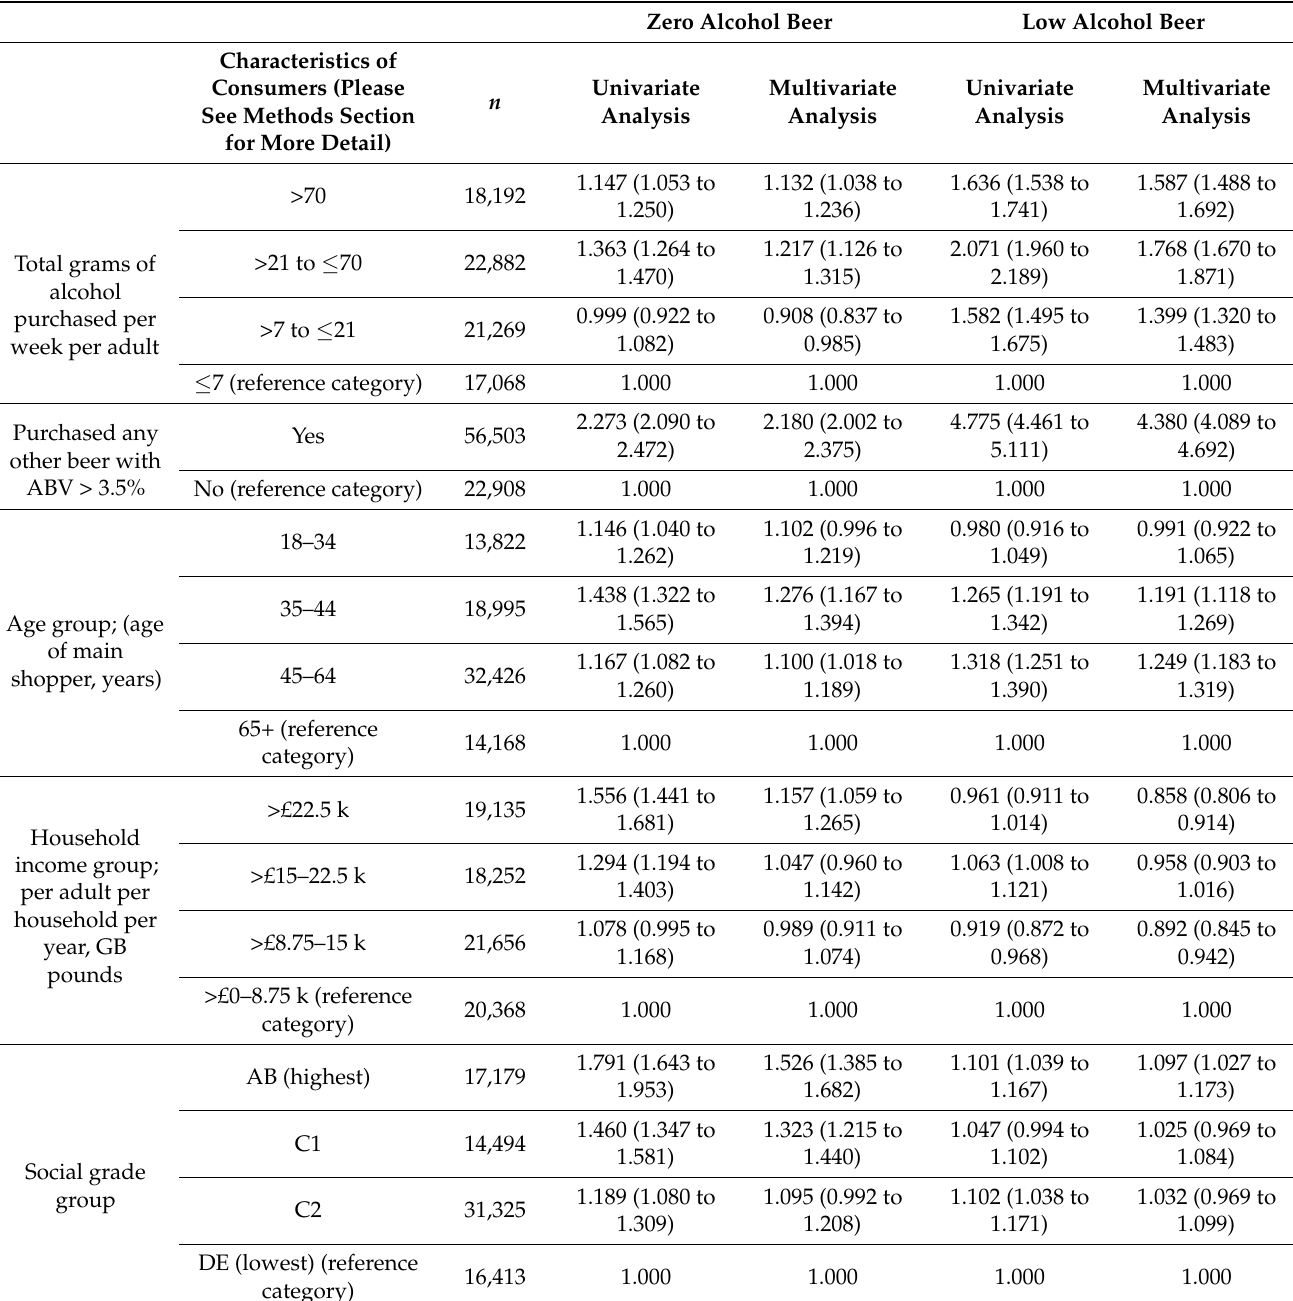
Table 1 gives the odds ratios (95% confidence intervals) for a household purchasing at least one zero alcohol beer and at least one low alcohol beer by household characteristics. Table 1. Analysis at level of each household; odds ratios (OR) (95% confidence intervals) for any purchase of zero alcohol beer (ABV = 0.0%) or low alcohol beer (ABV > 0.0% and ≤ 3.5%) by household socio-demographic characteristics. In bold: 95% confidence interval does not cross